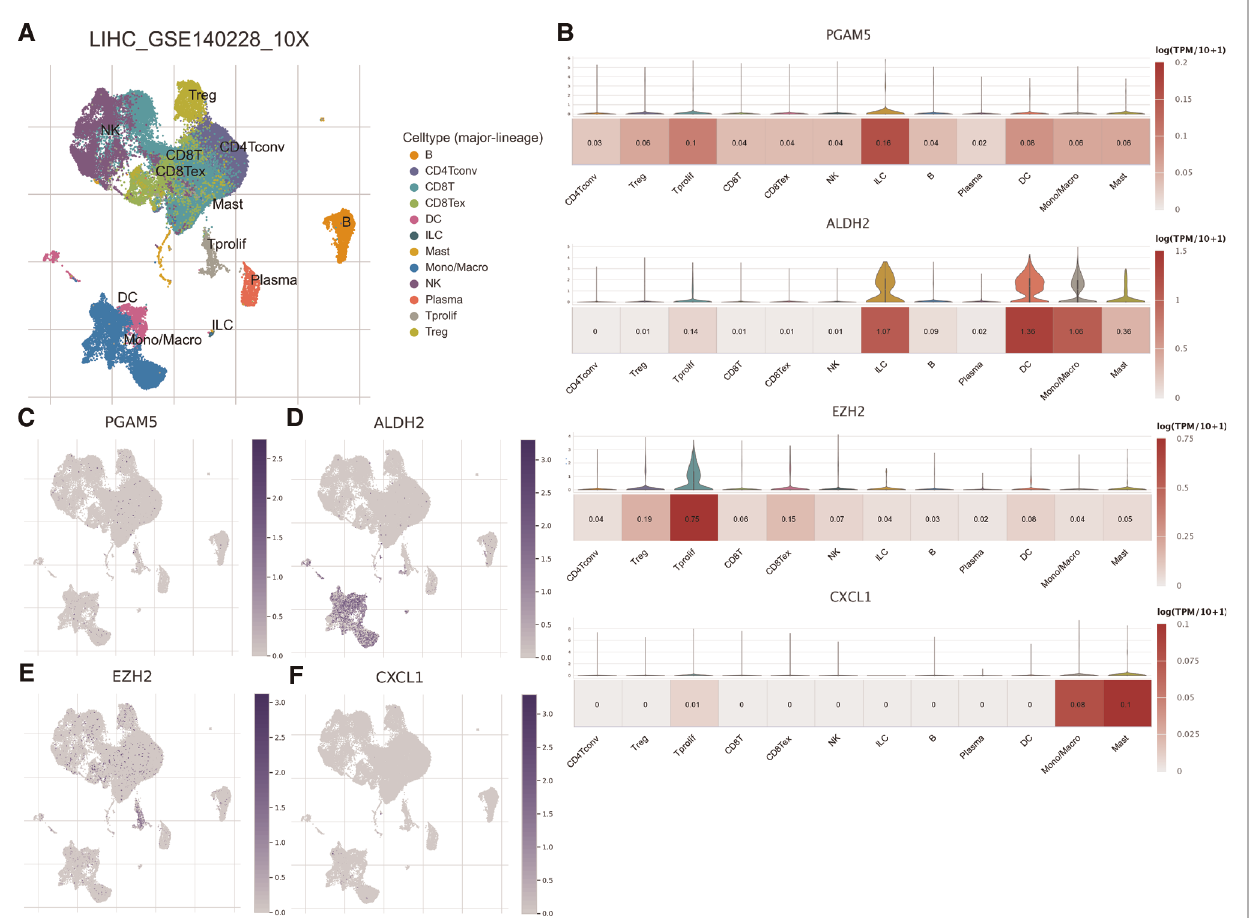
FIGURE 12 | Distribution of key genes constituting the Risk Score Signature at the single-cell level. ( A ) Immune cells clustered in GSE140228. ( B ) Violin map and heat map of the expression of key genes in clustered immune cells. Umap map of the expression of PGAM5 ( C ), ADH2 ( D ), EZH2 ( E ), and CXCL1 ( F ) in clustered immune